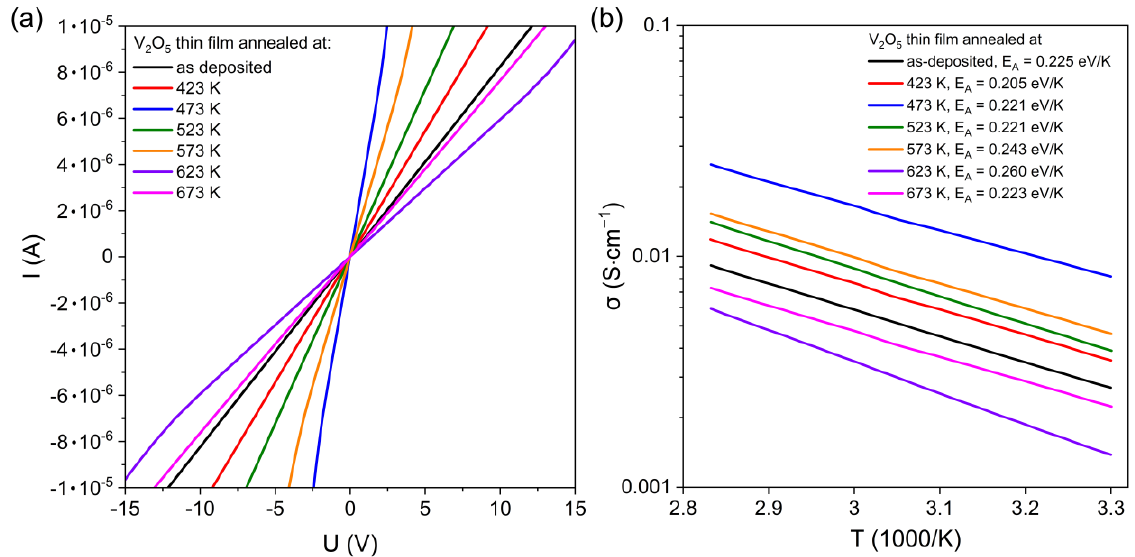
Figure 7. Results of electrical properties investigations: ( a) current-voltage characteristics and ( b ) conductivity as a function of 1000/T measured for vanadium oxide thin films annealed at various temperatures.